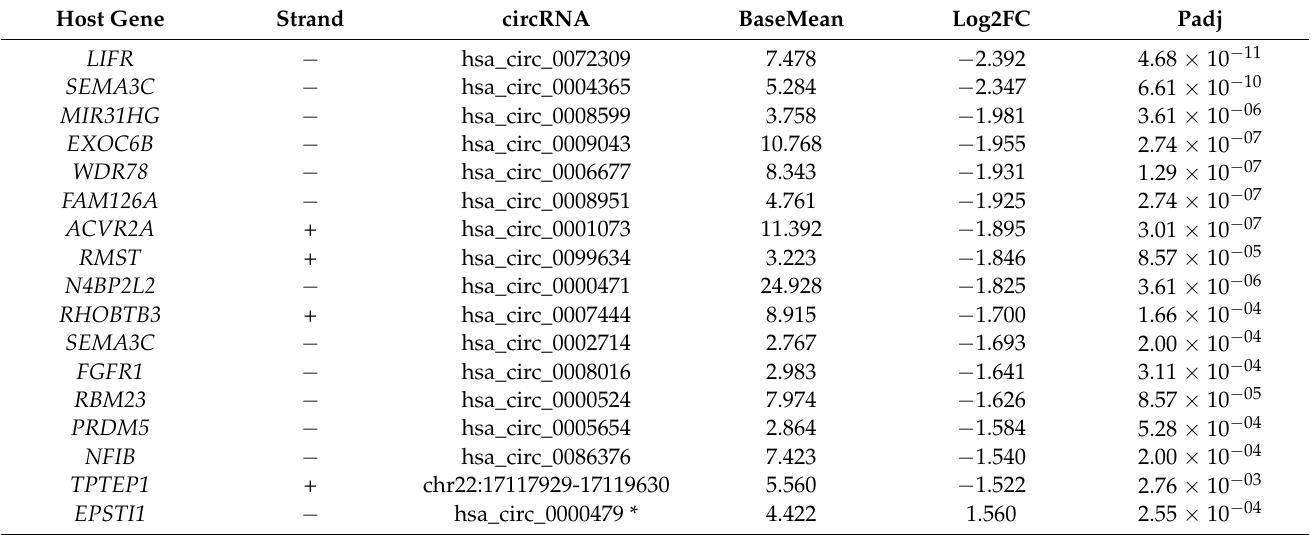
Table 2. Differentially expressed circRNAs in TNBC.